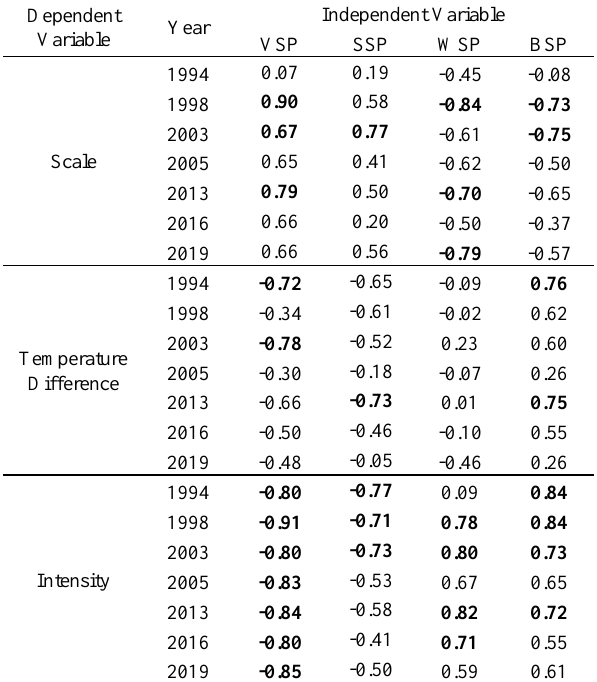
Table 7. Summary of Pearson correlation analysis between UCI indices and Land cover proportions – vegetation surface proportion (VSP), soil surface proportion (SSP), water surface proportion (WSP), and built-up surface proportion (BSP) (r values in bold text are statistically significant with p <